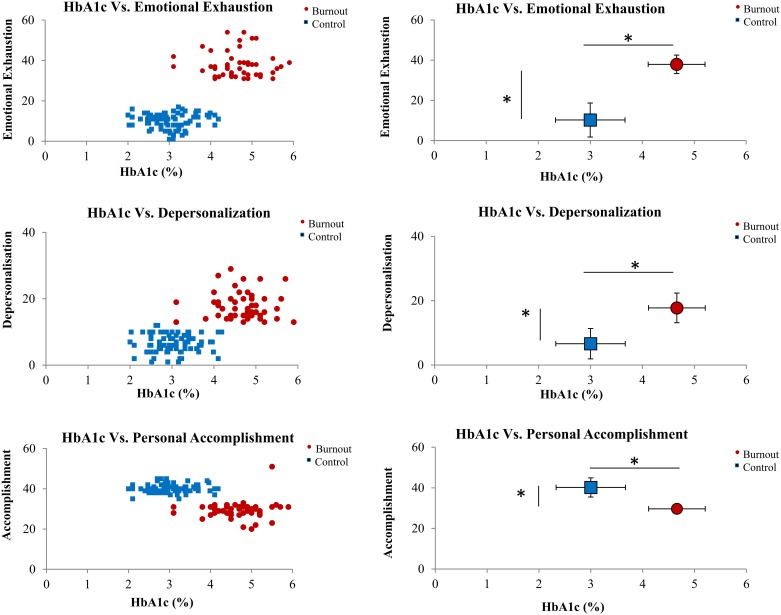
Comparison between HbA1C (individual and mean values (mean ± standard error) and the three burnout dimensions (emotional exhaustion, depersonalization and personal accomplishment) in control and burnout subjects.*p<0.05.